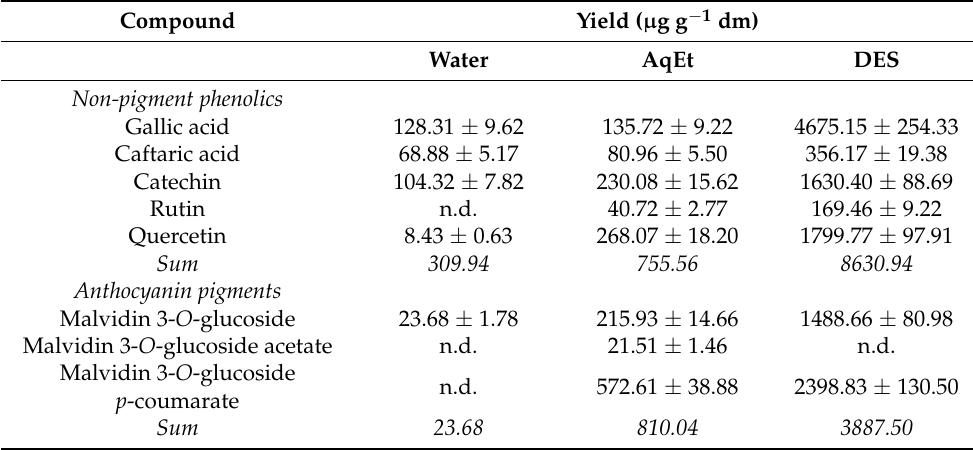
Table 4. Quantitative data on the polyphenolic composition of extracts obtained with the DES (GL-SBz) and the control solvents under optimized conditions. Values represent means of triplicate determination ( ± standard